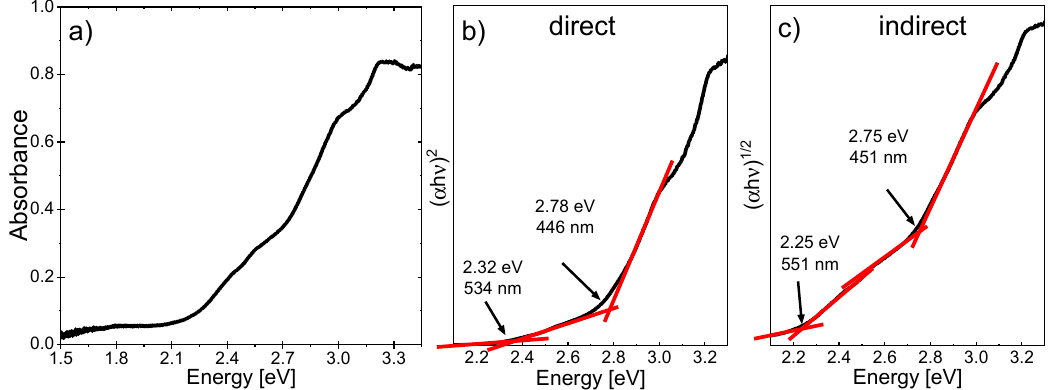
Figure 6. Absorbance spectra for the PFN layer from UV-Vis absorption measurements ( a ). Tauc plots for direct ( b ) and indirect ( c ) band gap.